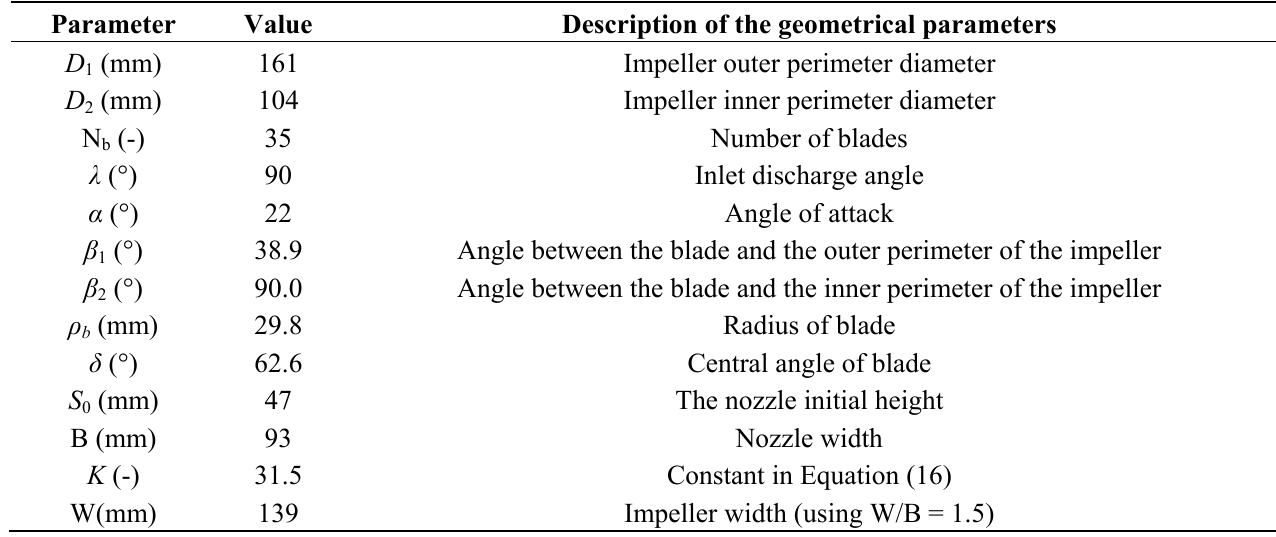
Table 4. Optimum geometry of the cross flow